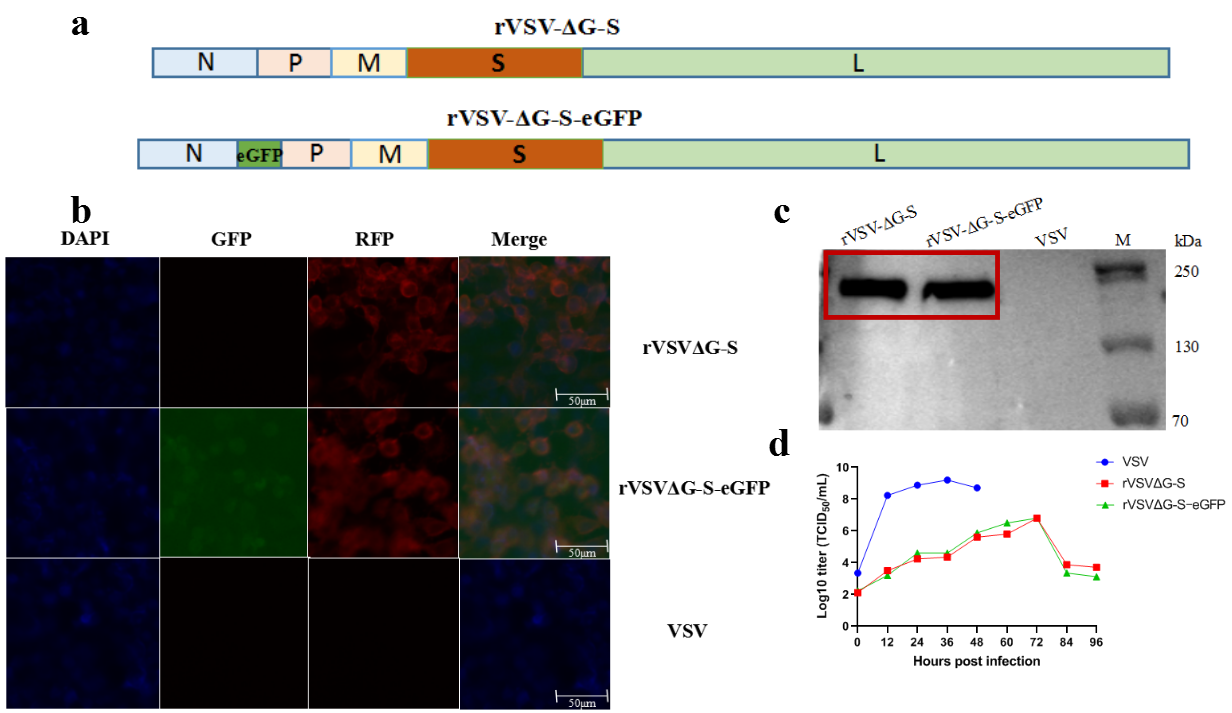
Figure 1. Characterization of the recombinant VSV viruses. ( a ) Schematic diagrams showing genome organization of the rVSV. VSV g was replaced by SARS-CoV-2 S to generate rVSV-ΔG-S and rVSV-ΔG-S-eGFP. ( b ) Indirect immunofluorescence identification results of rVSV-ΔG-S and rVSV-ΔG-S-eGFP. Vero E6 cells were infected with rVSV-ΔG-S or rVSV-ΔG-S-eGFP and recognized by SARS-CoV-2-specific antibody and Alexa Fluor 568-conjugated secondary antibody, presented red fluorescence, rVSV-ΔG-S-eGFP presented green fluorescence. No fluorescence signal was observed in the VSV control. ( c ) Lysates of rVSV-ΔG-S/rVSV-ΔG-S-eGFP-infected Vero E6 cells, and VSV-infected Vero cells were blotted with an antibody recognizing SARS-CoV-2 S protein, a band representing S at 190 kDa was detected in rVSV-ΔG-S and rVSV-ΔG-S-eGFP group, no band was observed in the VSV control. ( d ) Growth kinetics of rVSV-ΔG-S, rVSV-ΔG-S-eGFP and VSV. Vero E6 cells were infected with the recombinant VSV viruses (MOI = 0.01) and virus titers in the supernatant were measured at the indicated time points post-infection.